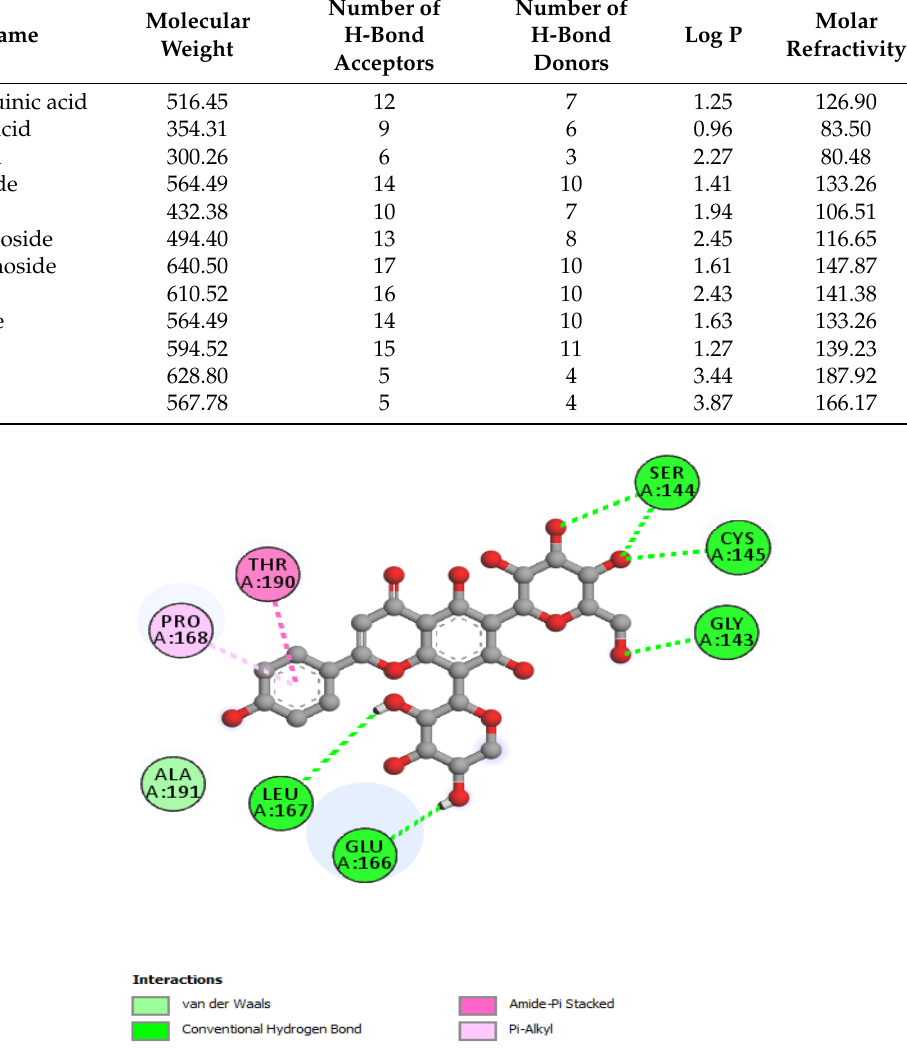
Figure 4. 2D interactions of schaftoside with Mpro.